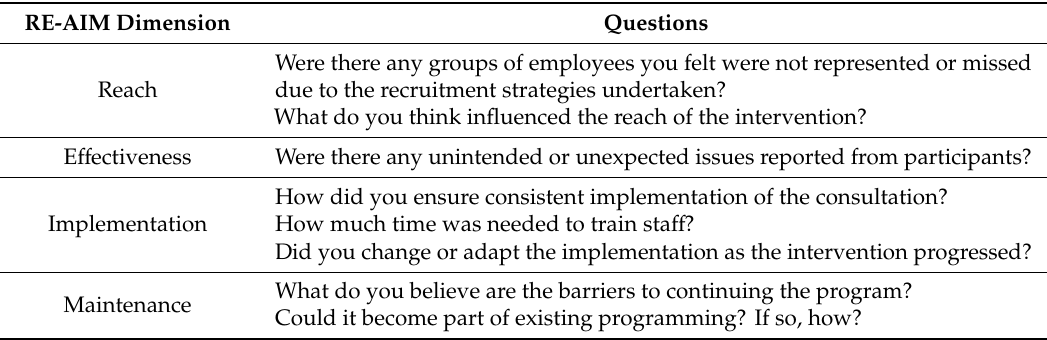
Table 2. Example questions from key informant interview topic